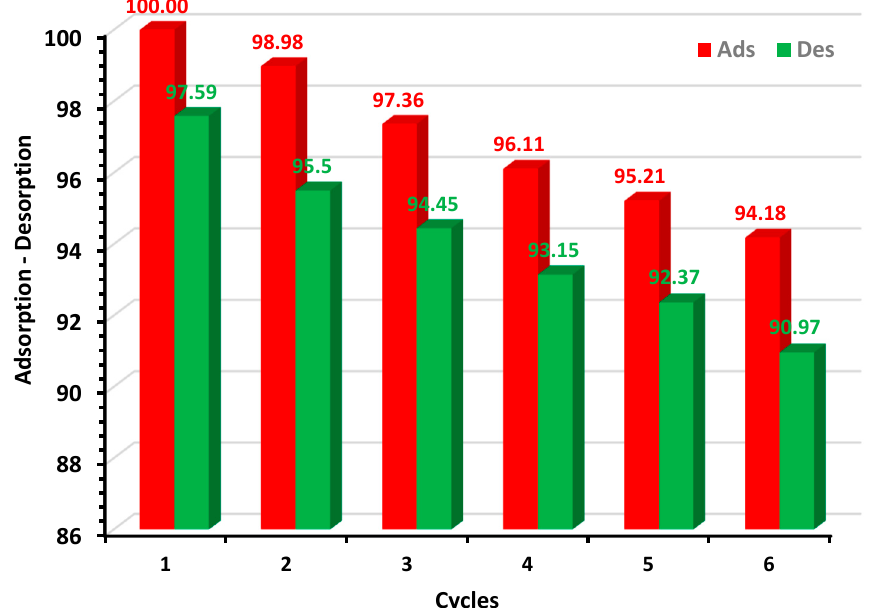
Figure 13. Adsorption–desorption studies for AC-ZnCl 2 recycle studies.